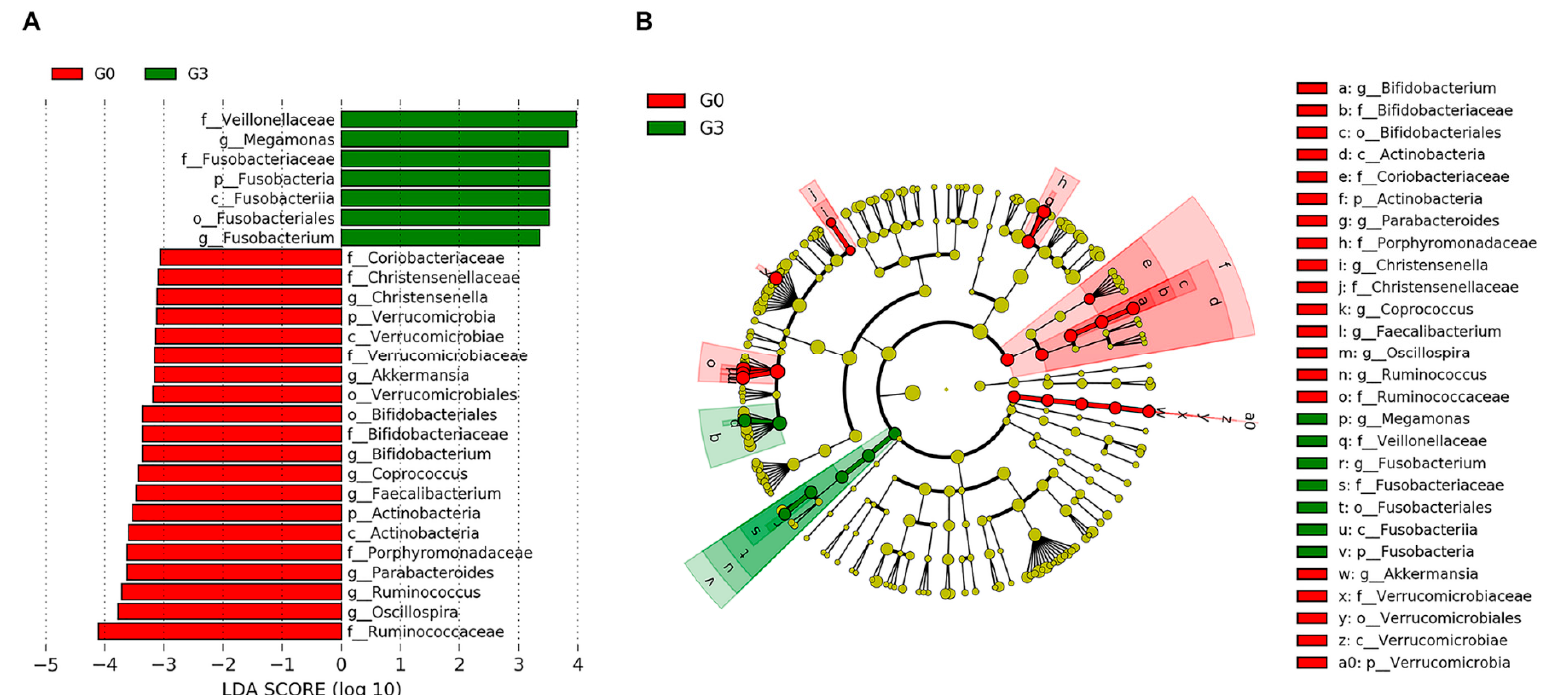
Figure 4. Differentially abundant bacterial taxa in fecal samples from the control (G0) and the persistent nonalcoholic fatty liver disease (NAFLD) group. ( A ) A forest plot showing the linear discriminant analysis (LDA) score (effect size) indicating significant differences in the bacterial taxa between the G0 (red) and G3 (green) groups (LDA score > 3.0; p < 0.05). ( B ) Cladogram generated using the LDA effect size (LEfSe) method indicating the phylogenetic distribution of microbes associated with the G0 and G3 groups.